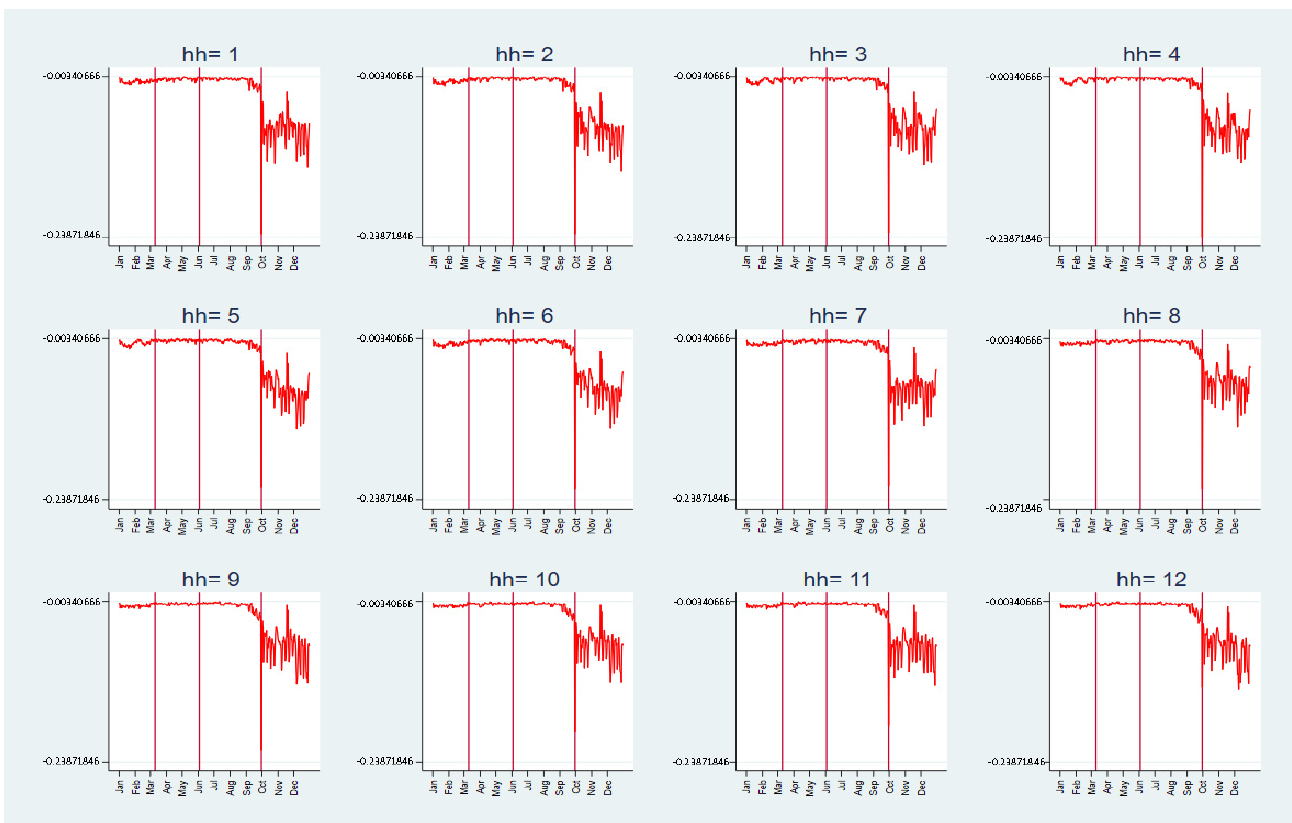
Figure 7. Hourly elasticity estimates for the hours 1 a.m.–12 a.m., 2020.